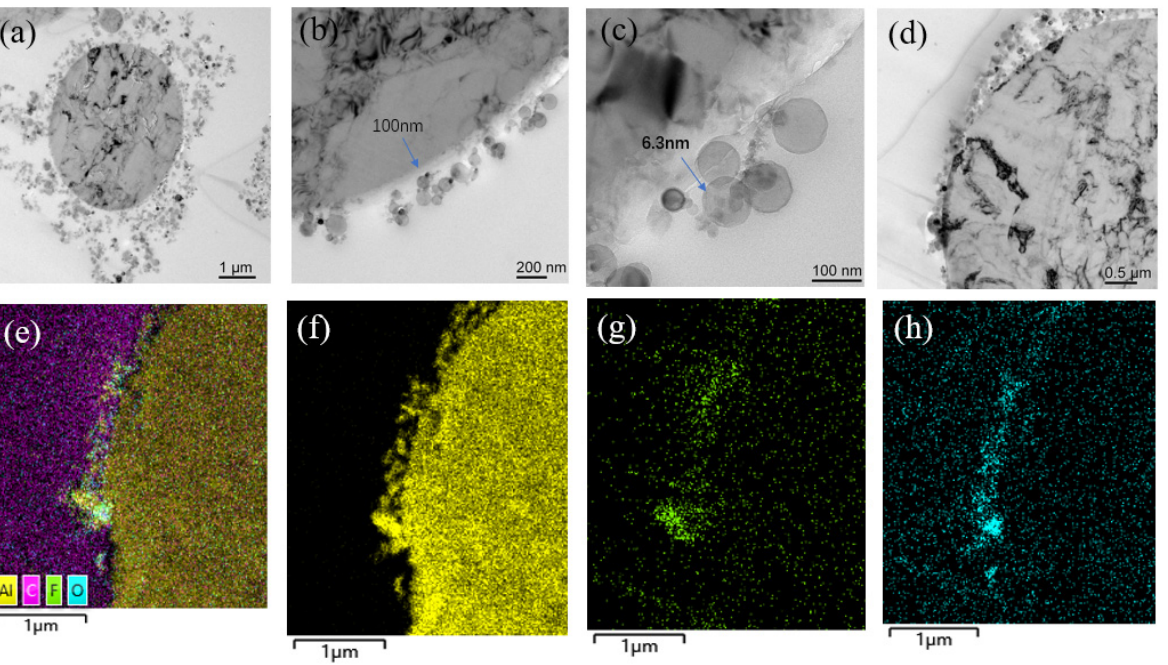
Figure 3. TEM and EDS of the micro-nano composite aluminum powder, micro structure from ( a – d ), and element distribution from ( e – h ).